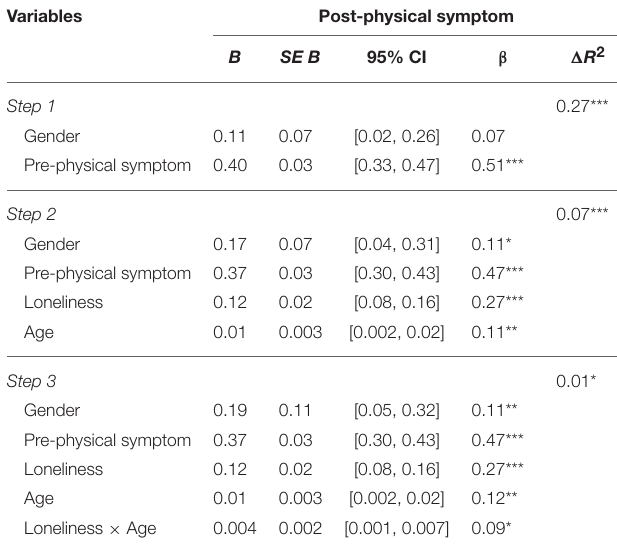
TABLE 5 | Summary of hierarchical regression analysis for variable predicting post physical symptom in Study 2.